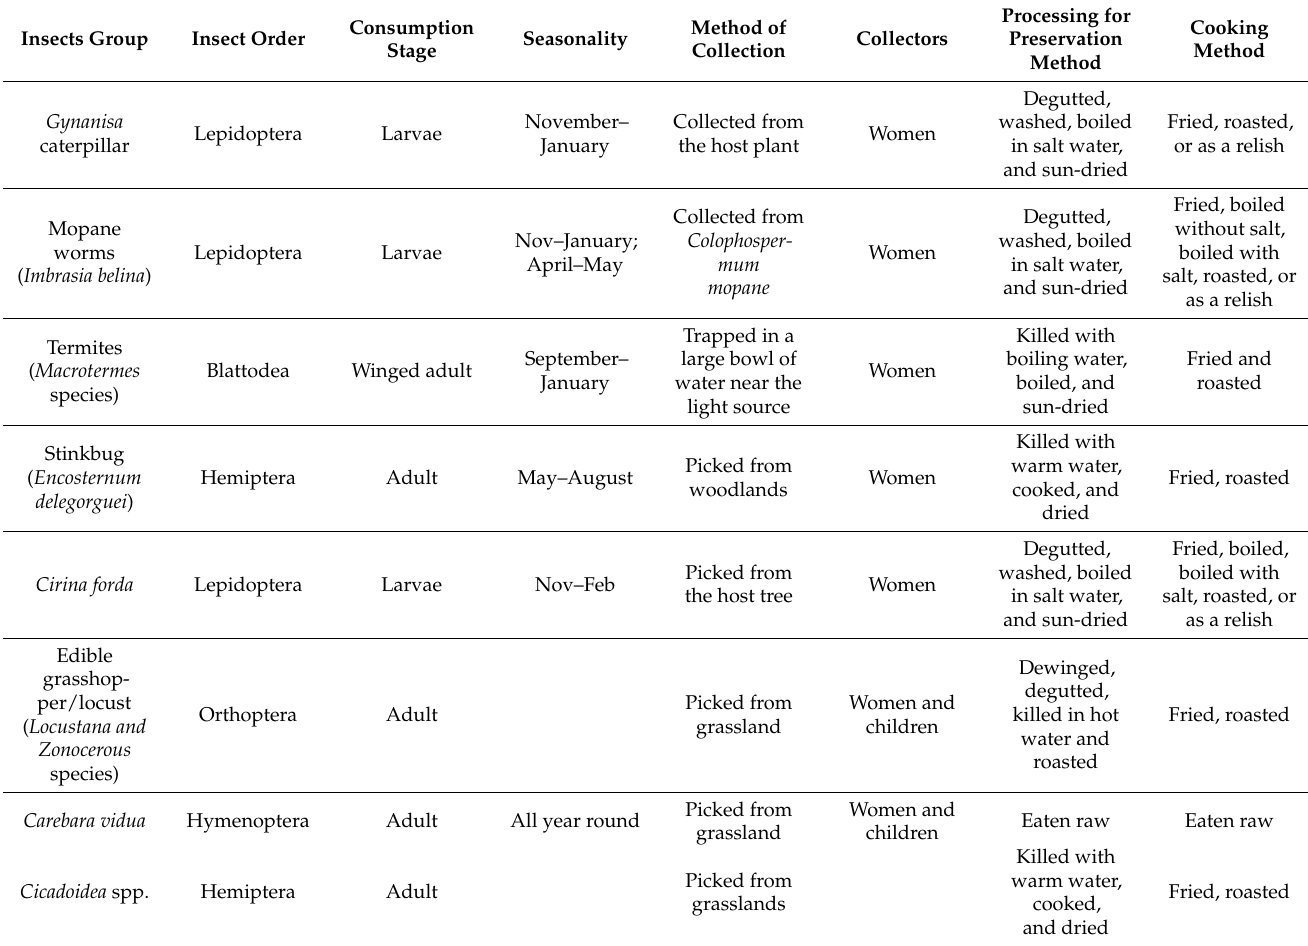
Table 4. Traditional collection and preparation methods of the commonly consumed insects in KZN and Limpopo provinces of South Africa.